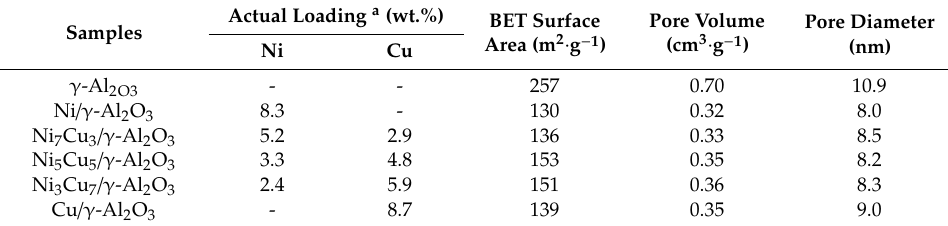
Samples Table 1. Chemical composition and textural properties of fresh Ni x Cu (10 − x ) / γ -Al 2 O 3 catalysts. Samples